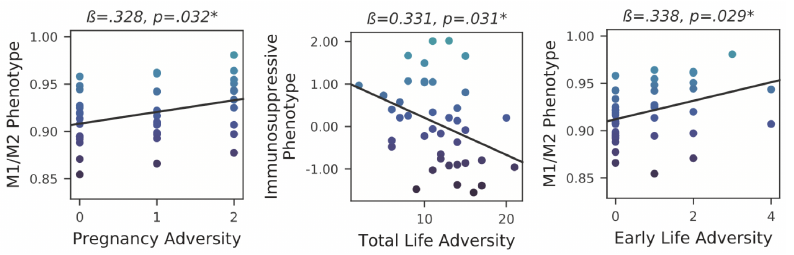
Figure 3. Depending on when the exposure occurred, different immunological phenotypes are linked to hardship in life. * for p <